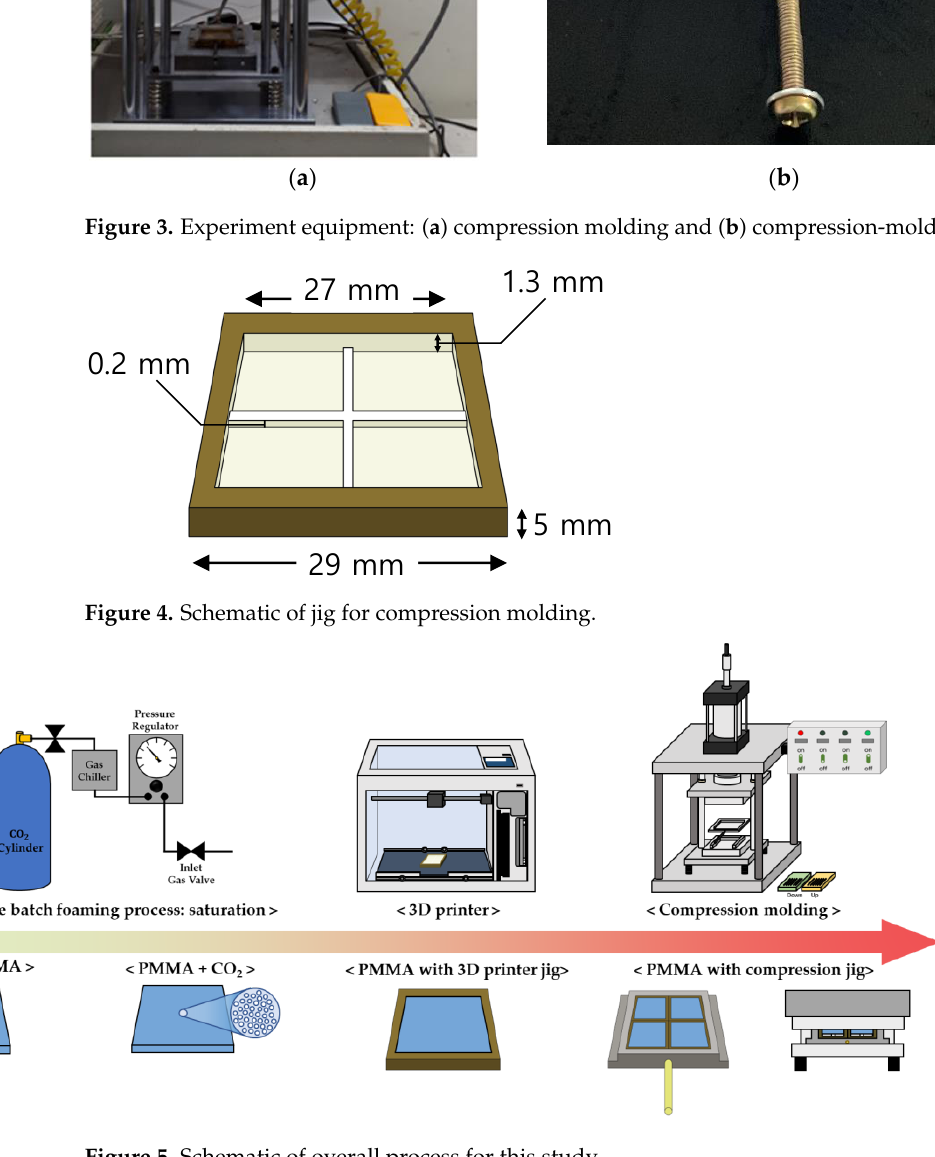
Figure 5. Schematic of overall process for this study.